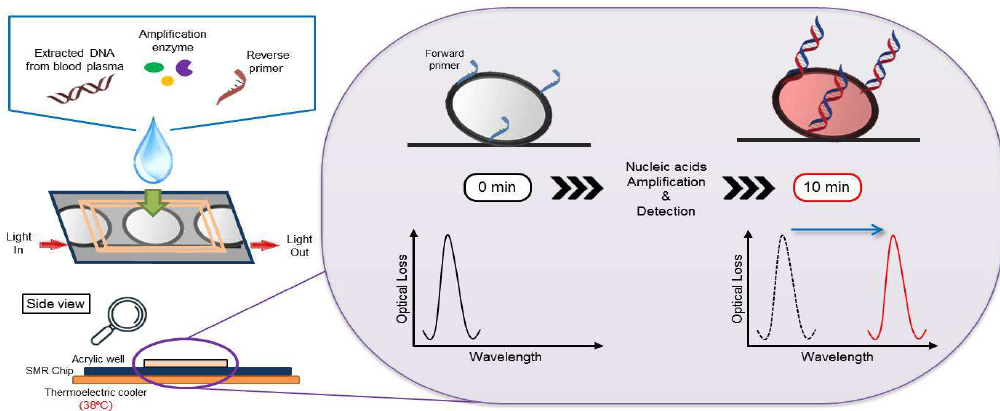
Figure 1. Schematic representation of the principle of isothermal nucleic acid amplification and detection using a silicon microring resonator sensor in clinical blood plasma specimens. In the isothermal condition (38 °C), the DNA is hybridized with immobilized DNA primer and the target sequence is amplified by the RPA reagent. The resonant wavelength is shifted over time by nucleic acid amplification on the sensor microring and measured in a real-time manner. Table 1. Comparison of the current and previous system of the silicon microring resonator (SMR) sensor. Content Current Previous [30]